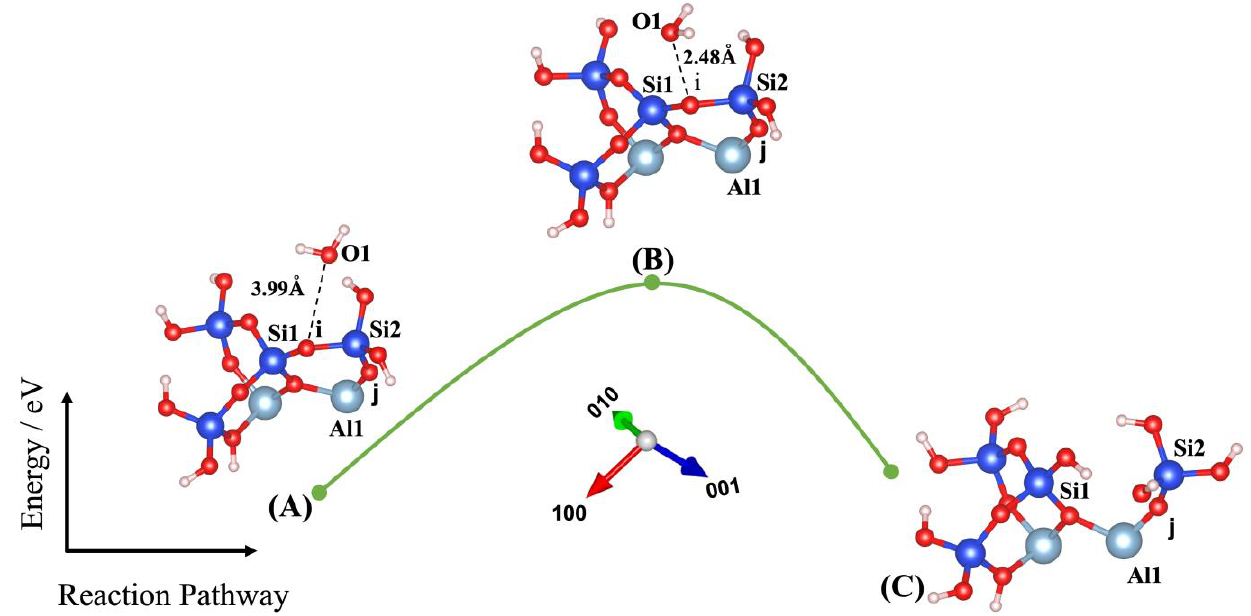
Figure 3. Model 1: ( A ) Ground state obtained as an optimized geometric structure of reactant, including water molecule as absorbent on MK surface (001) for attacking and breaking the bridging oxygen, bonded to the silicate neighbor (Si1). ( B ) Transition state at the saddle point using improved dimer method. ( C ) Ground state obtained as an optimized geometric structure of product after protonation of the bridging oxygen to the silicate neighbor. The structural building units are described in caption of Figure 2. E _reactant, E _transition state, and E _product have been collected in Table 1.